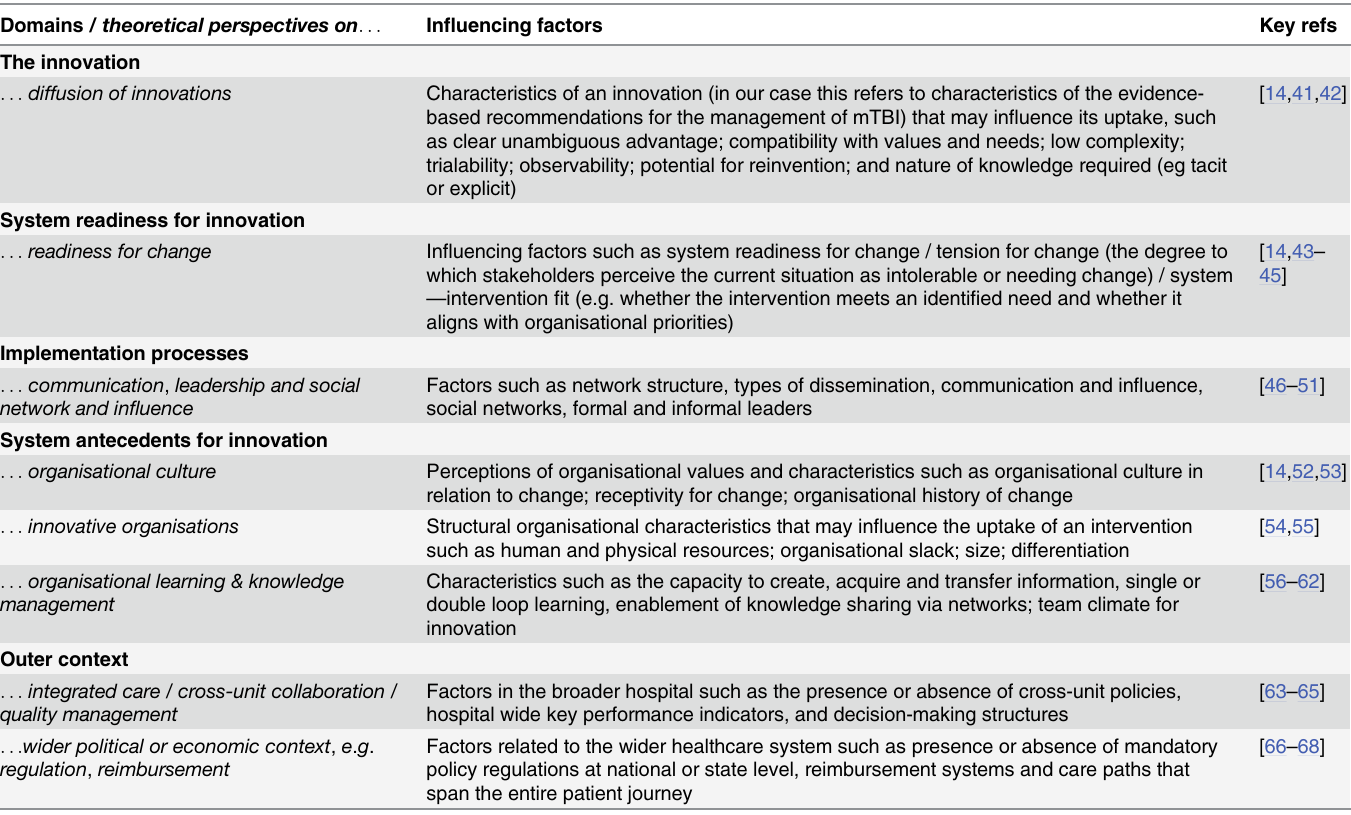
Table 2. Domains, theoretical perspectives and influencing factors. Domains / theoretical perspectives on